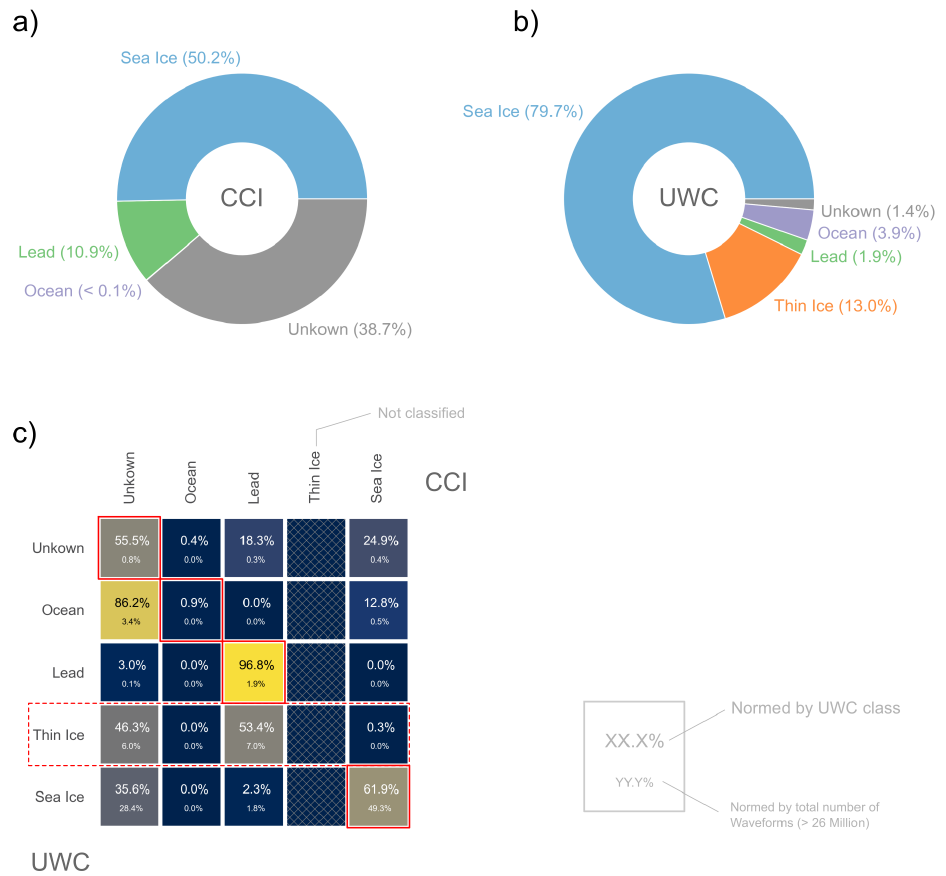
Figure 8. Surface type classification statistics of CryoSat-2 data for the Arctic Laptev Sea region (Fig. 1) for the ESA Climate Change Initiative (CCI) algorithm described in Paul et al. (2018) (a) , the unsupervised waveform classification (UWC) of this study (b) , and the classification matrix (c) . The colour coding of the classification matrix and the upper percent values describe the distribution of UWC classes within CCI classes for each class combination. The lower percent values describe the fraction of the total number of waveforms in the comparison ( > 26 × 10 6 ) in class combinations. The CCI surface type classification does not contain a thin-ice